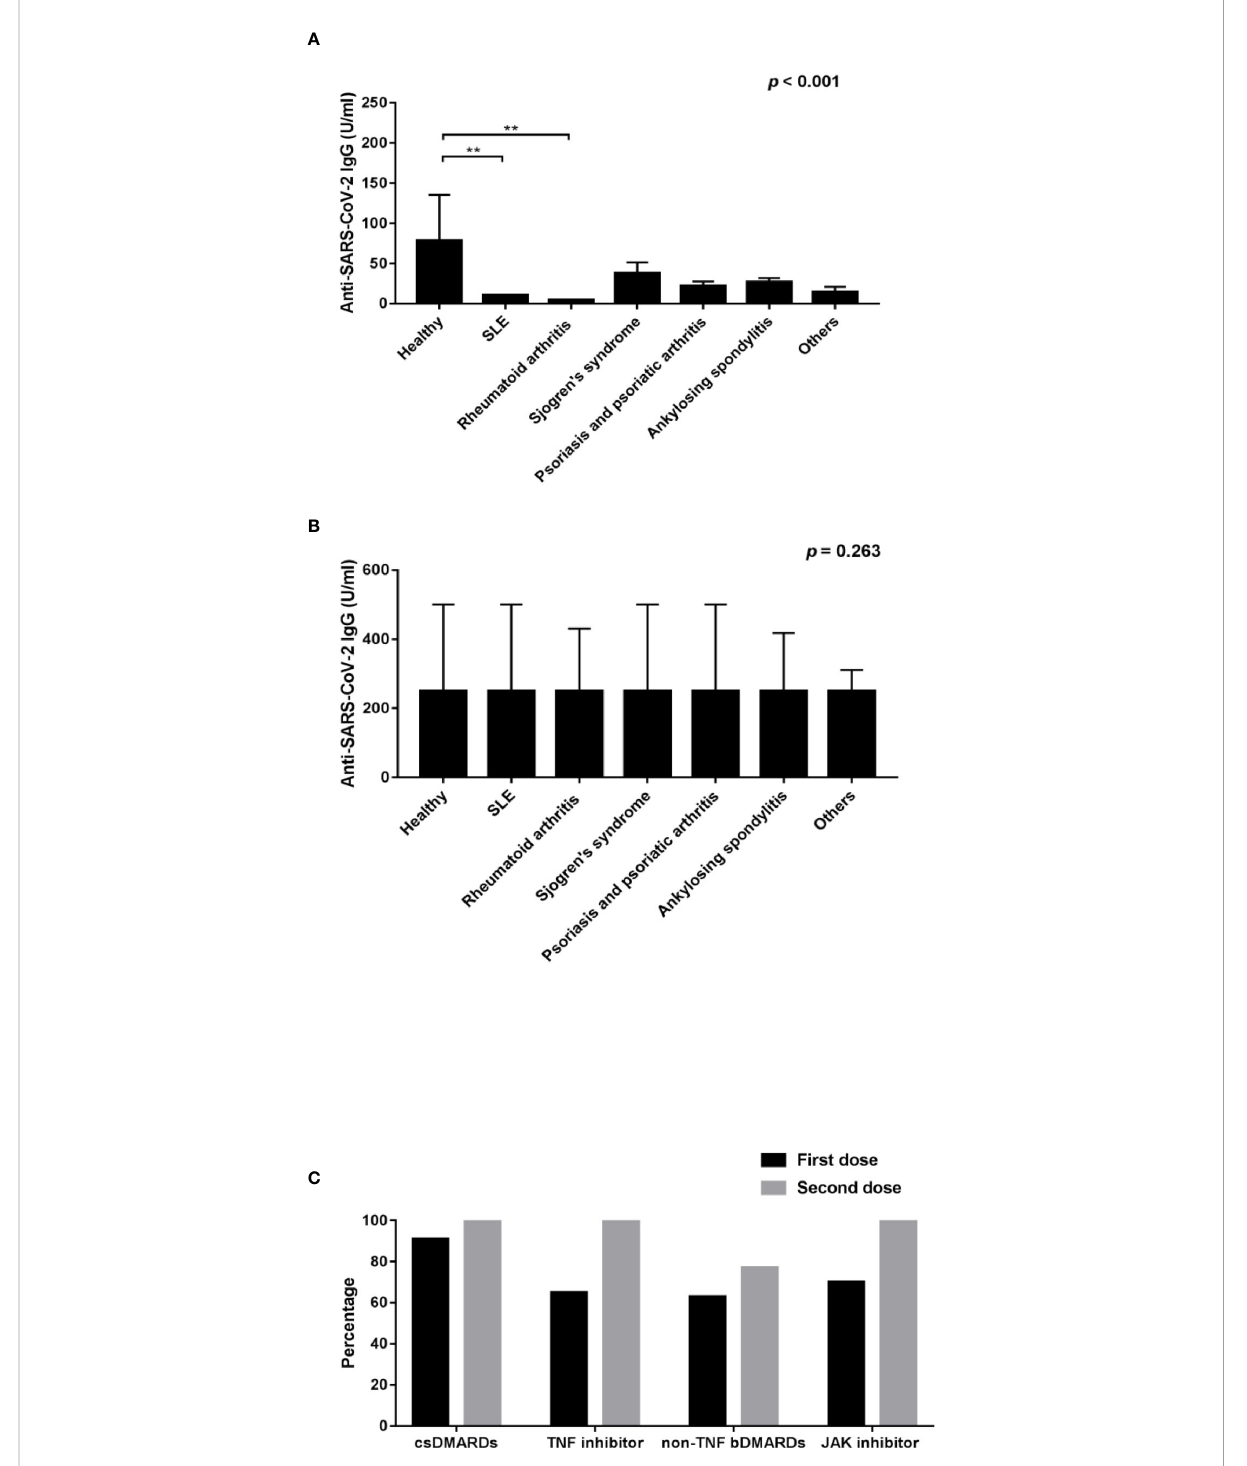
FIGURE 1 Comparison of the anti-SARS-CoV-2 IgG level after (A) the fi rst dose of COVID-19 vaccines and (B) the second dose of COVID-19 vaccines among healthy controls and patients with individual rheumatic diseases; and (C) comparison of the percentage of seropositivity rate of RA patients using csDMARDs, TNF inhibitors, non-TNF bDMARDs, and JAK inhibitors after the fi rst and second doses of COVID-19 vaccines. SLE, systemic lupus erythematosus; RA, rheumatoid arthritis; csDMARDs, conventional synthetic disease-modifying antirheumatic drugs; TNF, tumor necrosis factor; bDMARDs, biologic disease-modifying antirheumatic drugs; JAK, Janus kinase. **p <